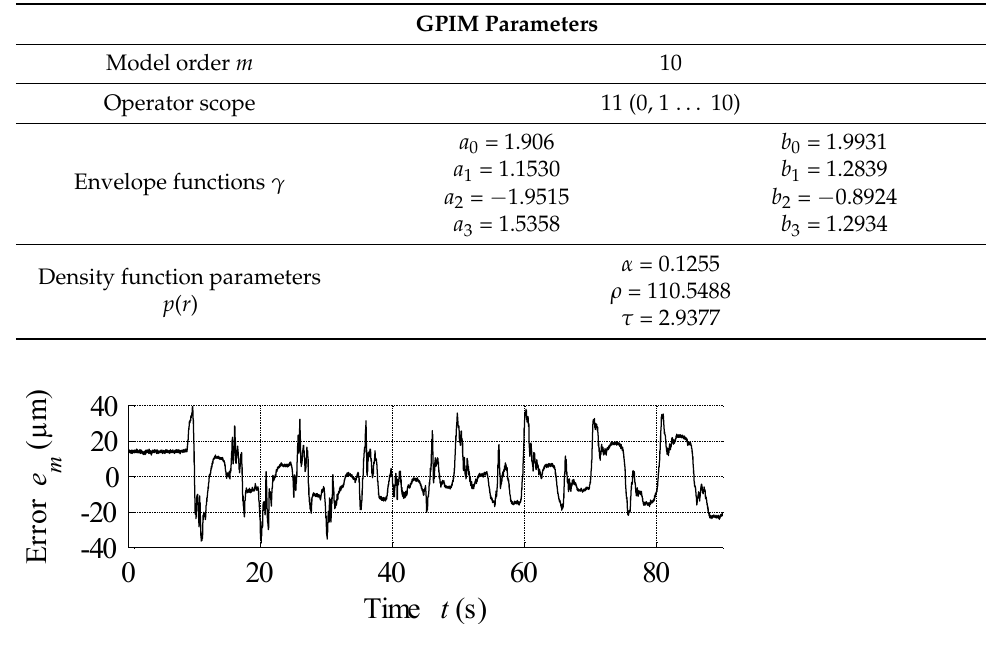
Figure 14. Modelling error between curves presented in Figure 13.